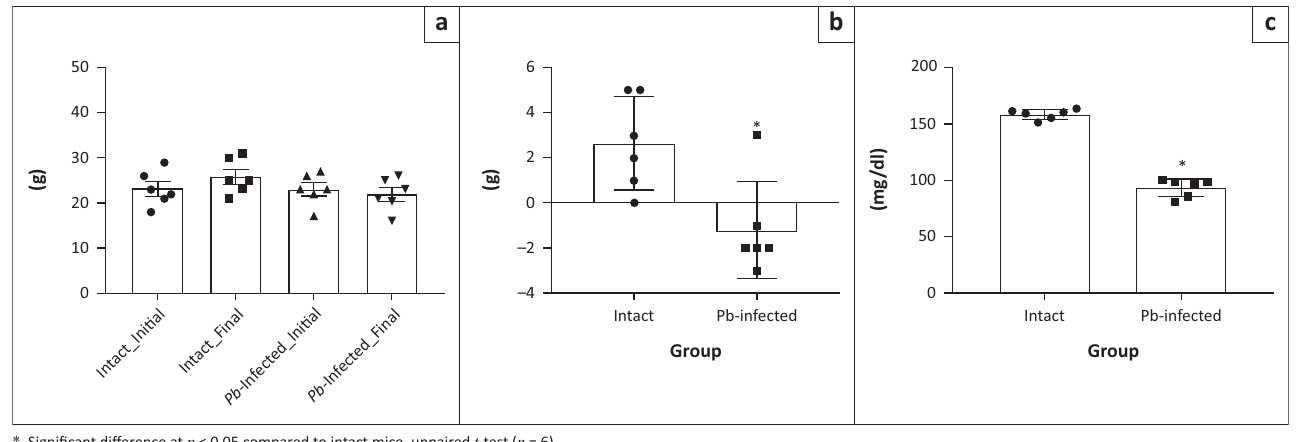
FIGURE 1: Body weight and blood glucose following Pb infection in Swiss mice. (a) Final body weight compared with initial weight. (b) Body weight difference pre- and post-infection periods. (c) Fasting blood glucose level at Day